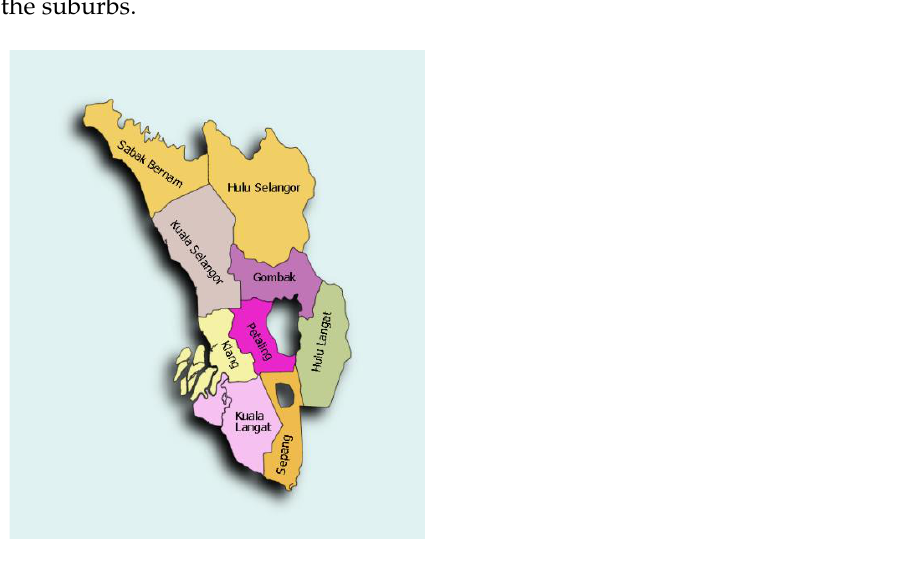
Figure 1. Map of Selangor showing the nine districts encircling Federal Territory, Kuala Lumpur.